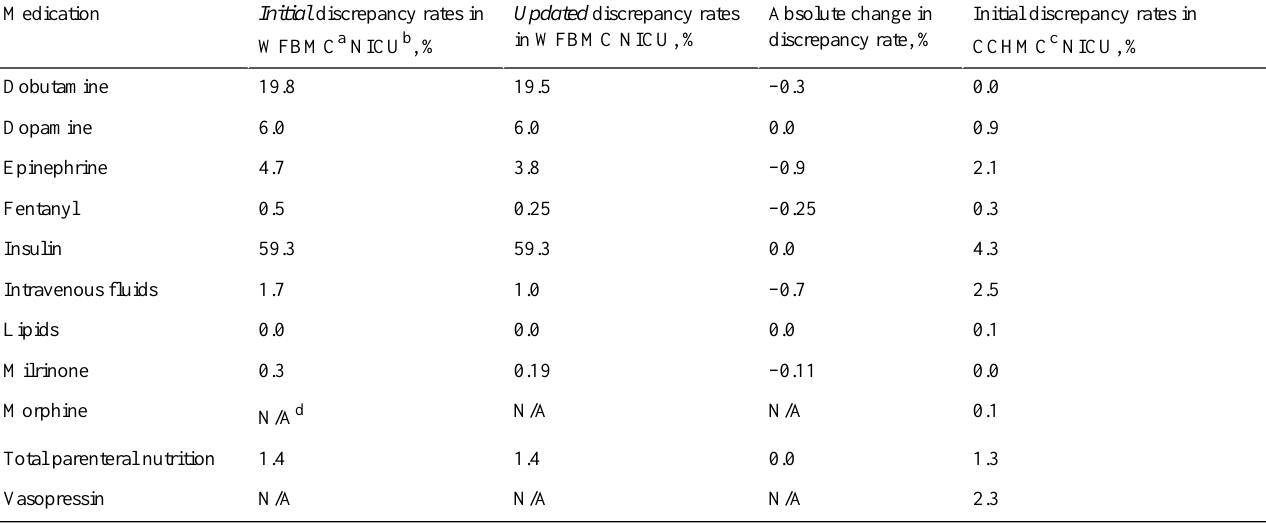
Table 3. Discrepancy rates of medication administration in the NICU before and after implementation of a software update at WFBMC in comparison to the site of development